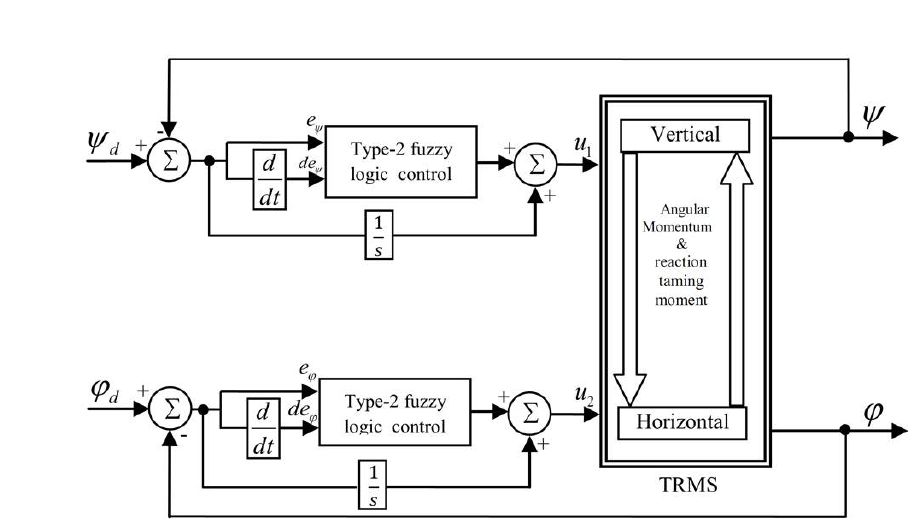
Figure 6. Block diagram of the proposed fuzzy type-2 control scheme.